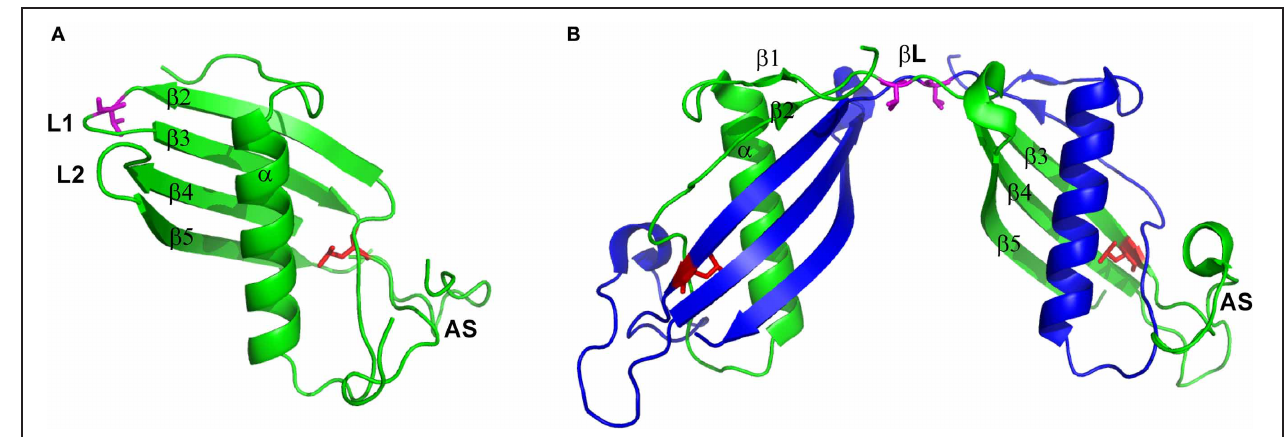
FIGURE 1 | Structure of (A) hCC monomer (stab1, PDB code: 3GAX) and (B) dimer (PDB code: 1G96). Valine residue in position 57 presented as magenta sticks and leucine in position 68 presented as red sticks. Figure prepared using PyMol